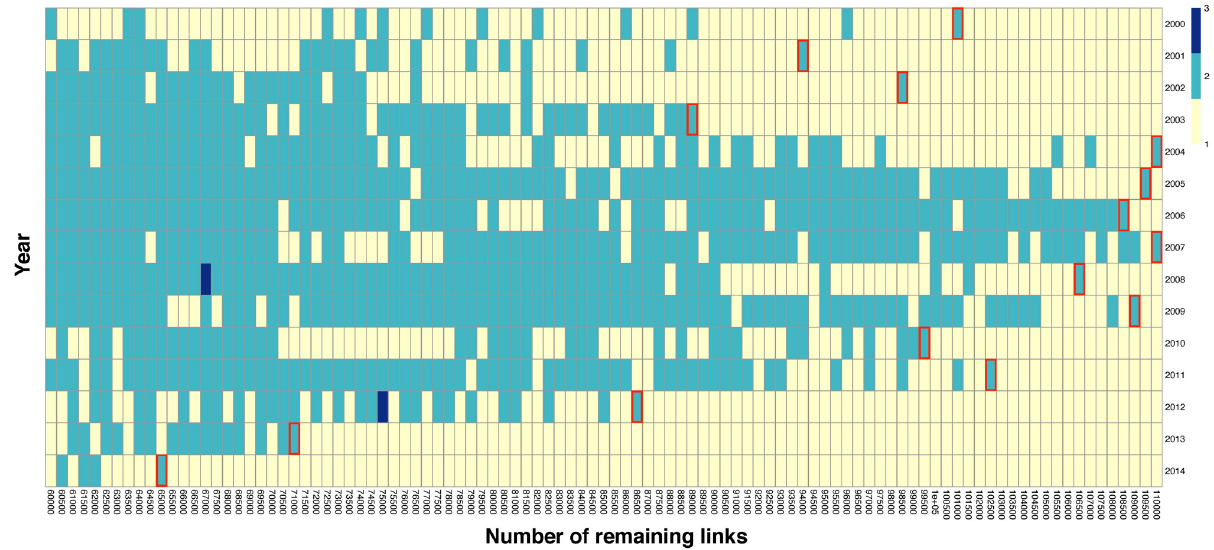
Fig 1. Heat map of the number of major communities in the IVANs cut by each threshold, in 2000–2014. This research uses the thresholds represented as a red-bordered cell in each year. Colors mean the number of major